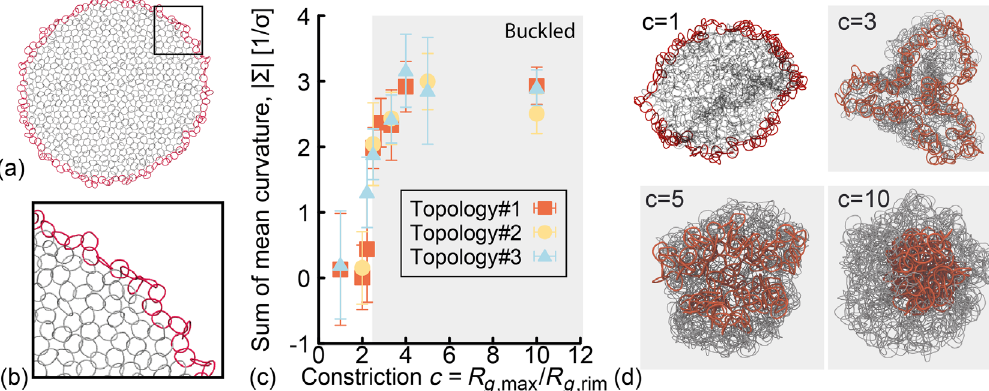
FIG. 4. (a) An in silico kDNA with hexagonal structure of rings. The border is highlighted in red. (b) Enlarged portion of (a) showing the hexagonal lattice linkages. See Supplemental Material [30] for details on how the network is built. (c) Absolute value of the sum of the mean curvature of the triangular mesh, j Σ j , calculated by joining the center of mass of the rings and plotted as a function of the =R constriction c ¼ R . In these simulations, R is user defined and steered using a harmonic potential. The plot shows an g; max g; rim g; rim abrupt buckling transition. Different symbols correspond to different network topologies chosen by random linking of neighboring rings while preserving the hexagonal structure. (d) Snapshots of the network at four different values of constriction c